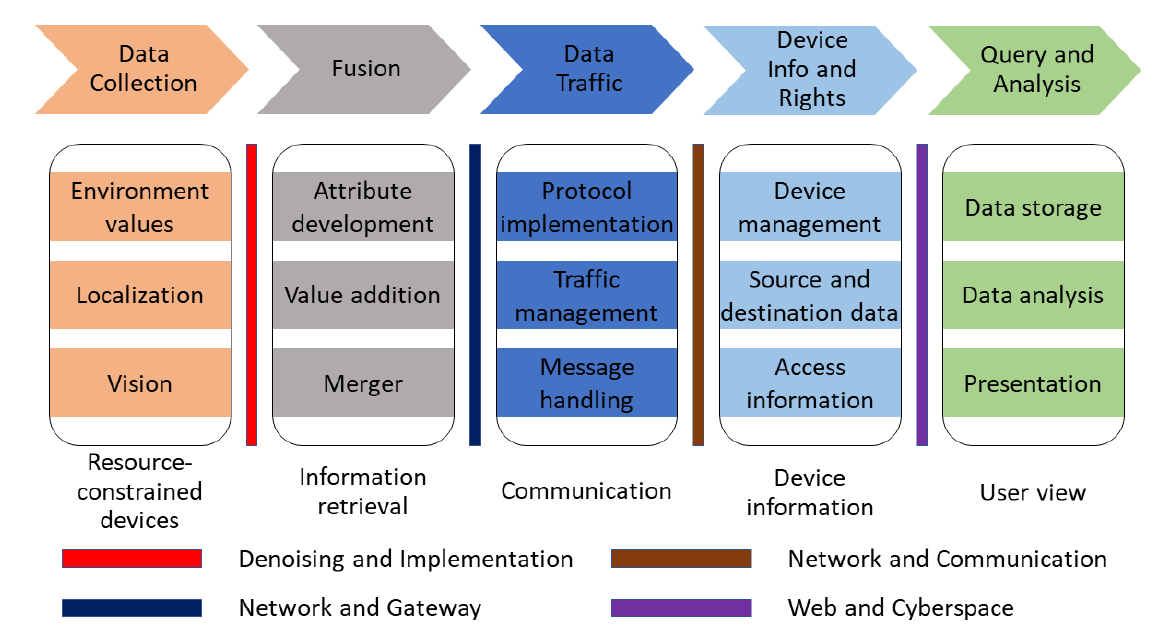
Figure 10. Layer-wise Security